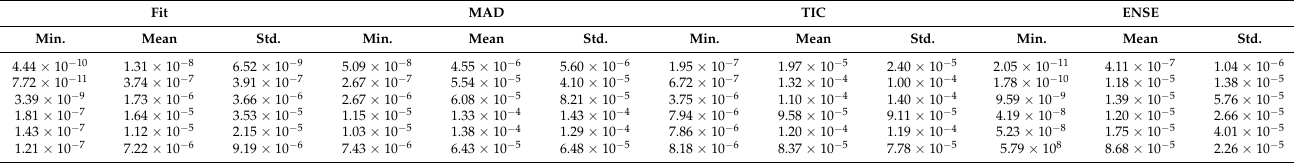
Table 7. Analysis of the values of fitness function and performance indices in term o minimum, mean, and standard deviations.